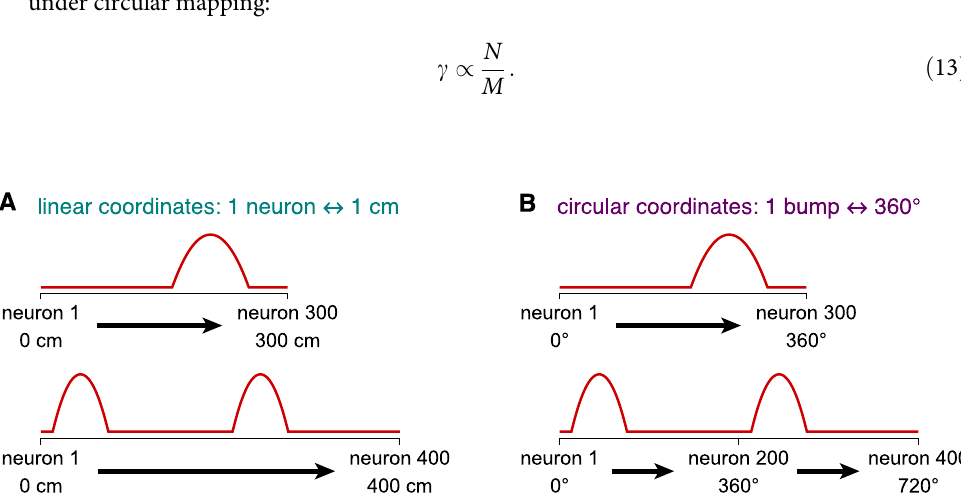
Fig 4. Possible mappings between network coordinates and two types of physical coordinates. ( A ) In networks encoding linear coordinates such as position, one neuron always represents a fixed physical interval. This mapping is trivial and identical to using network coordinates. ( B ) In networks encoding circular coordinates such as orientation, the bump distance always represents 360˚.